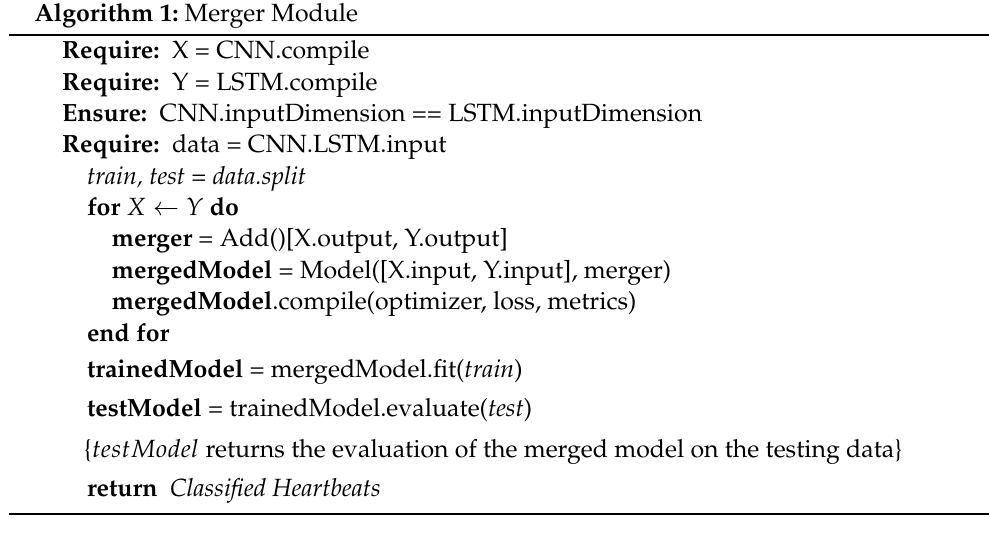
Algorithm 1: Merger